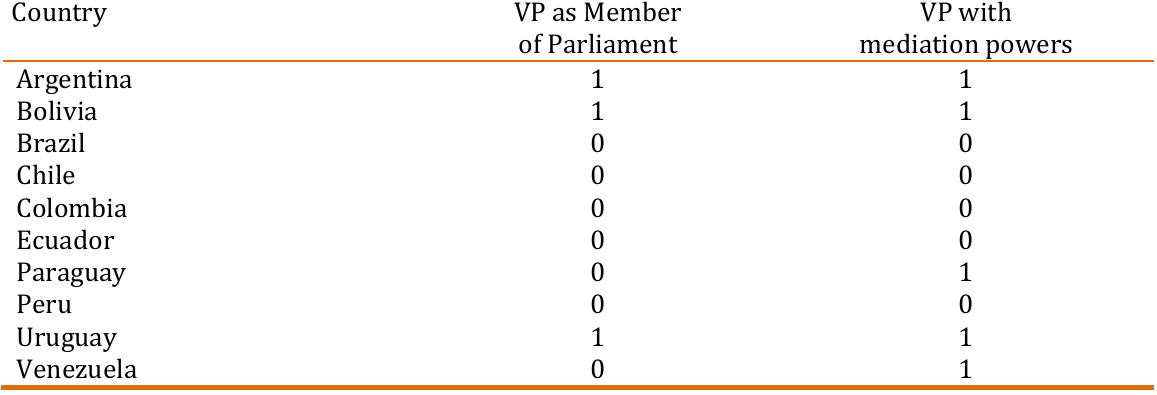
Table 02. Vice-Presidents in Executive-Legislative Intermediation Country VP as Member